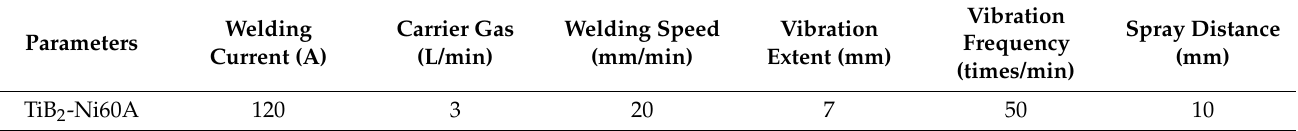
Table 1. Technological parameters of PTA + PMI.